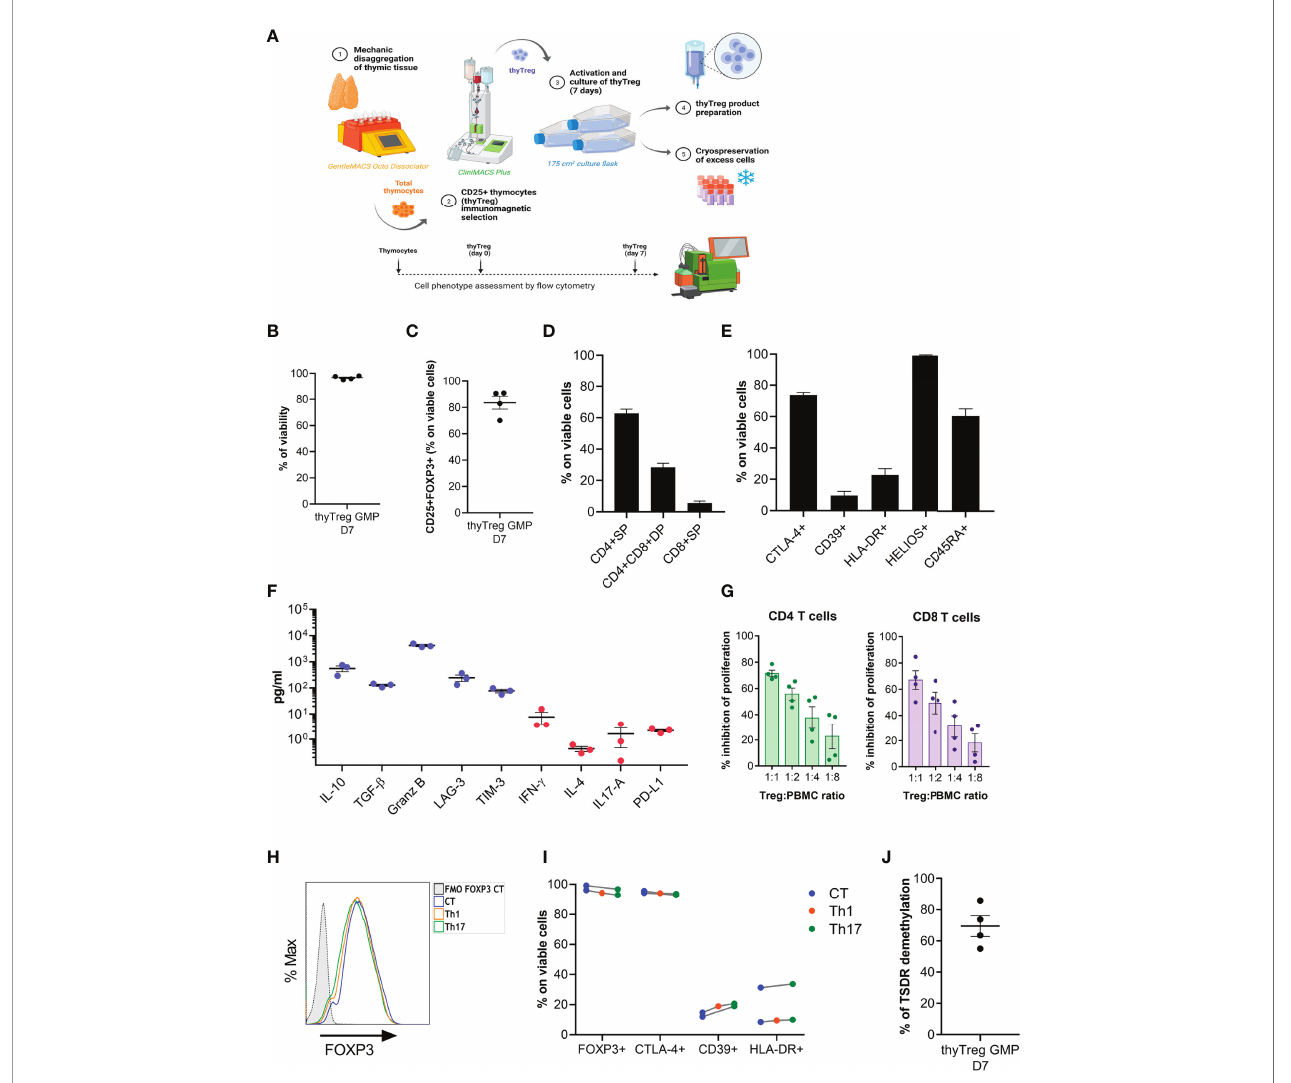
FIGURE 4 | GMP manufacturing of thyTreg. (A) Schematic representation of the procedure and equipment used in the Cell Production Unit for the thyTreg GMP manufacturing. Additionally, the dotted line represents the scheme of the quality evaluation process performed at different stages. (B – E) Summary of the cell viability (B) , purity (C) and phenotype (D, E) of n=4 GMP thyTreg. Graphs show mean ± SEM. (F) Quantitation of molecules secreted in day 7 GMP thyTreg culture supernatants. Anti-in fl ammatory molecules in blue; proin fl ammatory molecules in red. (G) Summary of the suppressive capacity of GMP thyTreg cells de fi ned as % inhibition of CD4 (green) and CD8 T (purple) cell proliferation at the indicated ratios. Graphs show mean ± SEM. (H) Representative fl ow cytometry histogram showing the stability of FOXP3 expression of GMP thyTreg cell product under control conditions (CT, blue) or under Th1 (orange) or Th17 (green) polarizing conditions evaluated after 3 days after re-stimulation. To determine the background signal, the fl uorescence minus one (FMO) of FOXP3 is shown. (I) Frequency of FOXP3, CTLA-4, CD39 and HLA-DR within GMP thyTreg under different polarizing conditions. (J) Global TSDR demethylation level (calculated as the mean of demethylation of the 11 CpGs) of GMP thyTreg cell product (n=4